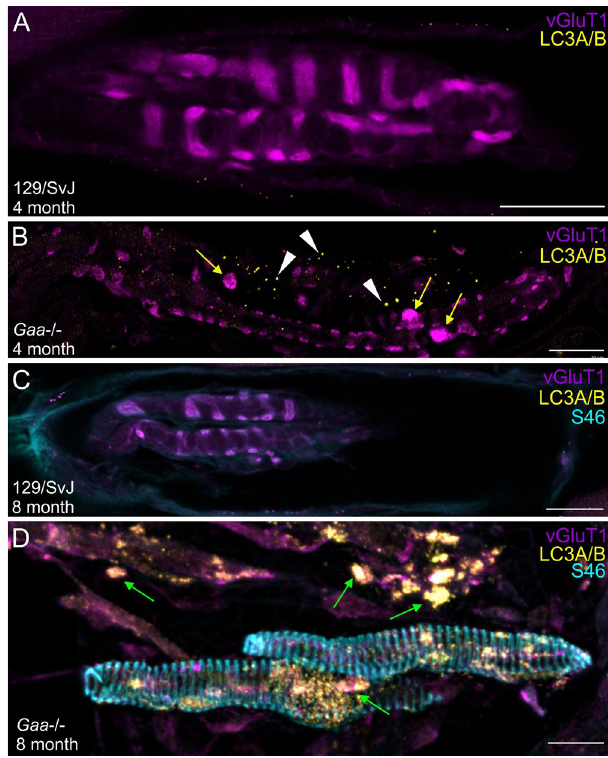
Figure 8. Autophagosomes accumulate in muscle spindles from Gaa −/− mice. Muscle spindles from 4- ( A,B ) and 8-month-old ( C,D ) wildtype ( A,C ) and Gaa −/− ( B,D ) mice were stained with antibodies against vGluT1 (purple channel) and the autophagosome marker LC3A/B (yellow channel). Muscle spindles from 8-month- old wildtype and Gaa −/− mice were additionally stained with antibodies against myosin heavy chain 6 (S46 antibody; blue channel in panels ( C,D )). While autophagosomes were mostly absent in muscle spindles from 4- and 8-month-old wildtype mice, they appeared in 4-month-old Gaa −/− mice (white arrowheads in panel ( B ); category 2 muscle spindle). In 8-month-old Gaa −/− mice autophagosomes were abundant (arrows in panel ( D ); category 3 muscle spindle) and the LC3A/B immunoreactivity was associated with intrafusal fibers (arrows in panel ( D )) and with the varicosities formed by the sensory nerve terminal (green arrows in panel ( D )). Note the formation of small varicosities by the sensory nerve terminal in muscle spindles from 4-month-old Gaa −/− mice (yellow arrows in panel ( B )). S46 immunoreactivity was absent in the central region of intrafusal fibers of 8-month-old 129/SvJ mice ( C ), but present in age-matched Gaa −/− mice ( D ), confirming the reorganization of the intrafusal contractile filaments. Scale bars: 20